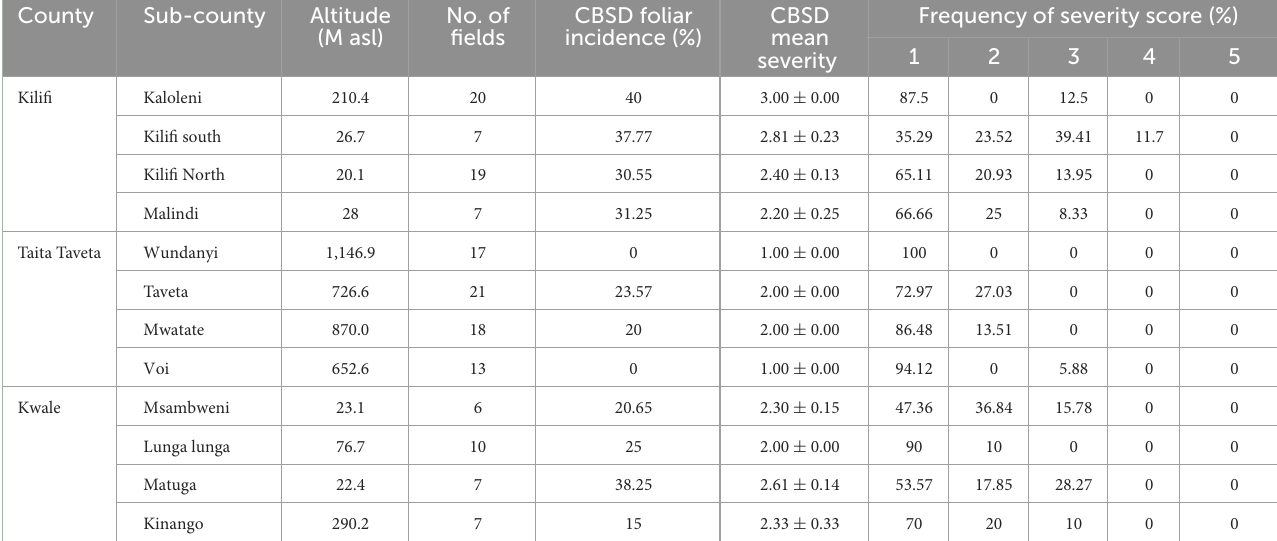
TABLE 6 Incidence and severity of CBSD in Kwale, Kilifi and Taita Taveta Counties of coastal Kenya.